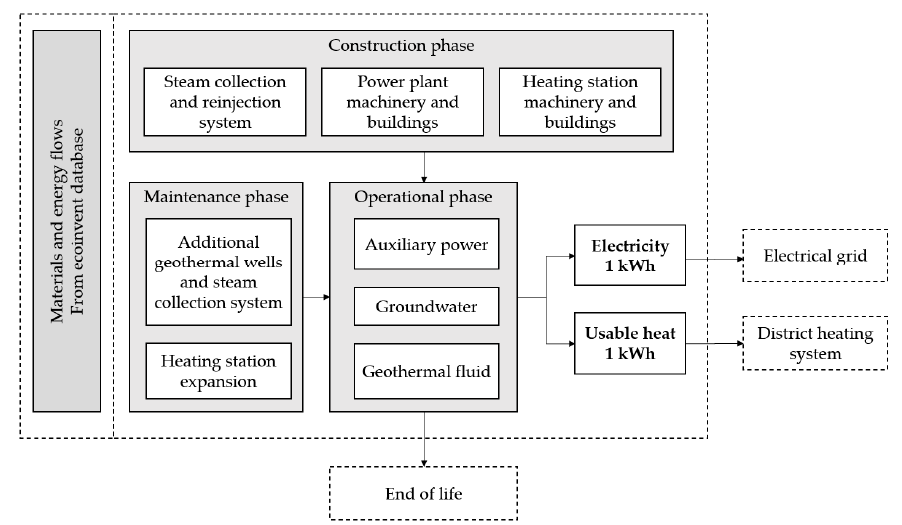
Figure 2. The system boundary for the Hellisheidi LCA study, showing the processes and life cycle stages included and excluded (dashed lined boxes) in the original study by Karlsdottir et al. [8].